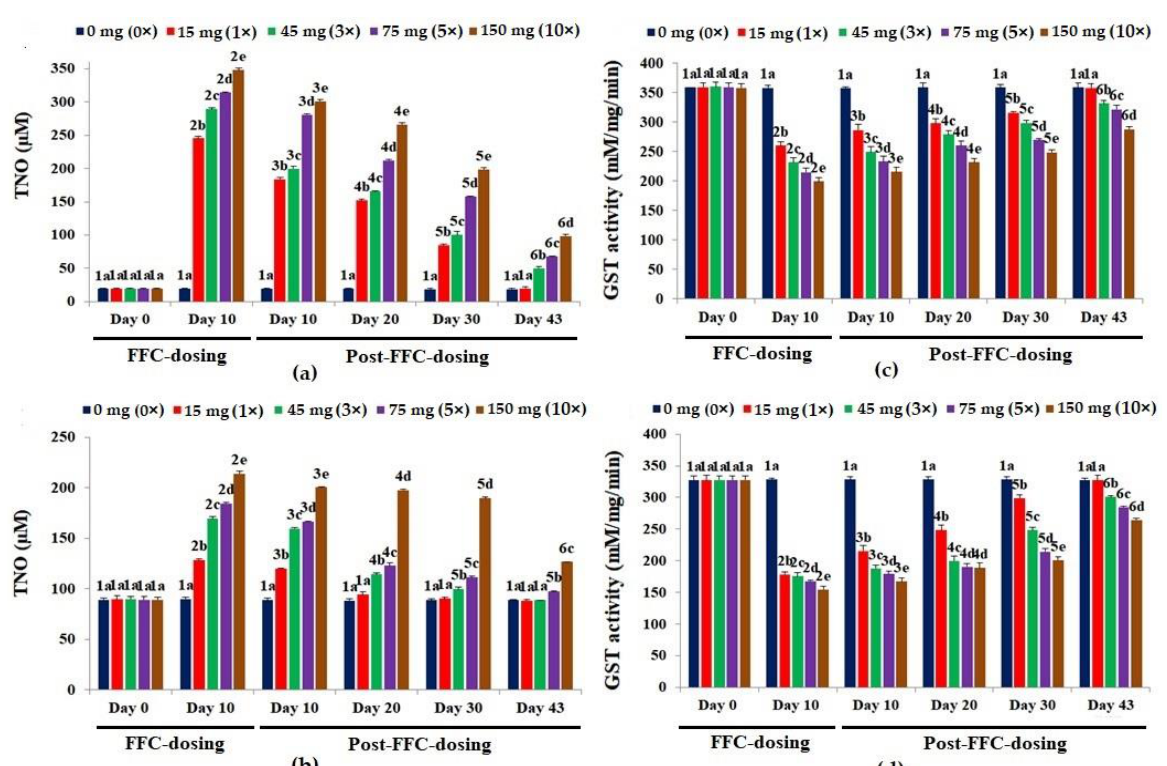
Figure 4. Levels of total nitric oxide [TNO] in the ( a ) liver and ( b ) kidney tissues and glutathione- S-transferase [GST] activity in the ( c ) liver and ( d ) kidney tissues of Oreochromis niloticus juveniles after dietary florfenicol (FFC) administration at 1–10 times the therapeutic dose of 15 mg kg biomass − 1 day − 1 for 10 consecutive days. a–e: Bars of a particular day showing common alphabets differed insignificantly ( p > 0.05). 1–6: Bars of a particular treatment (dose) showing common numerals differed insignificantly ( p > 0.05).